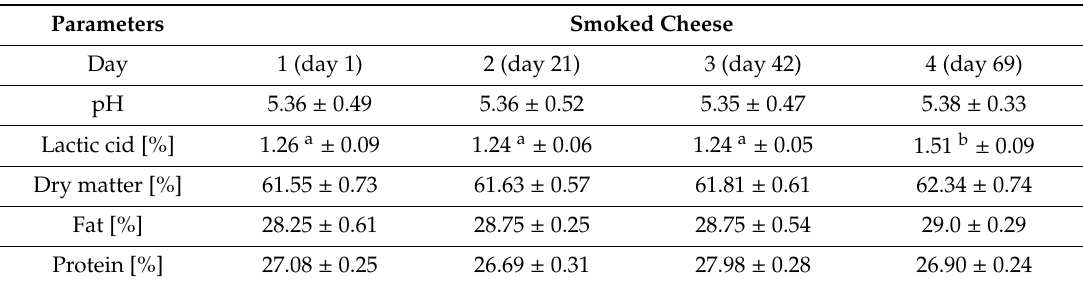
Table 1. Evolution of physicochemical properties of smoked cheese during 69 days of storage (mean ± SD, n =